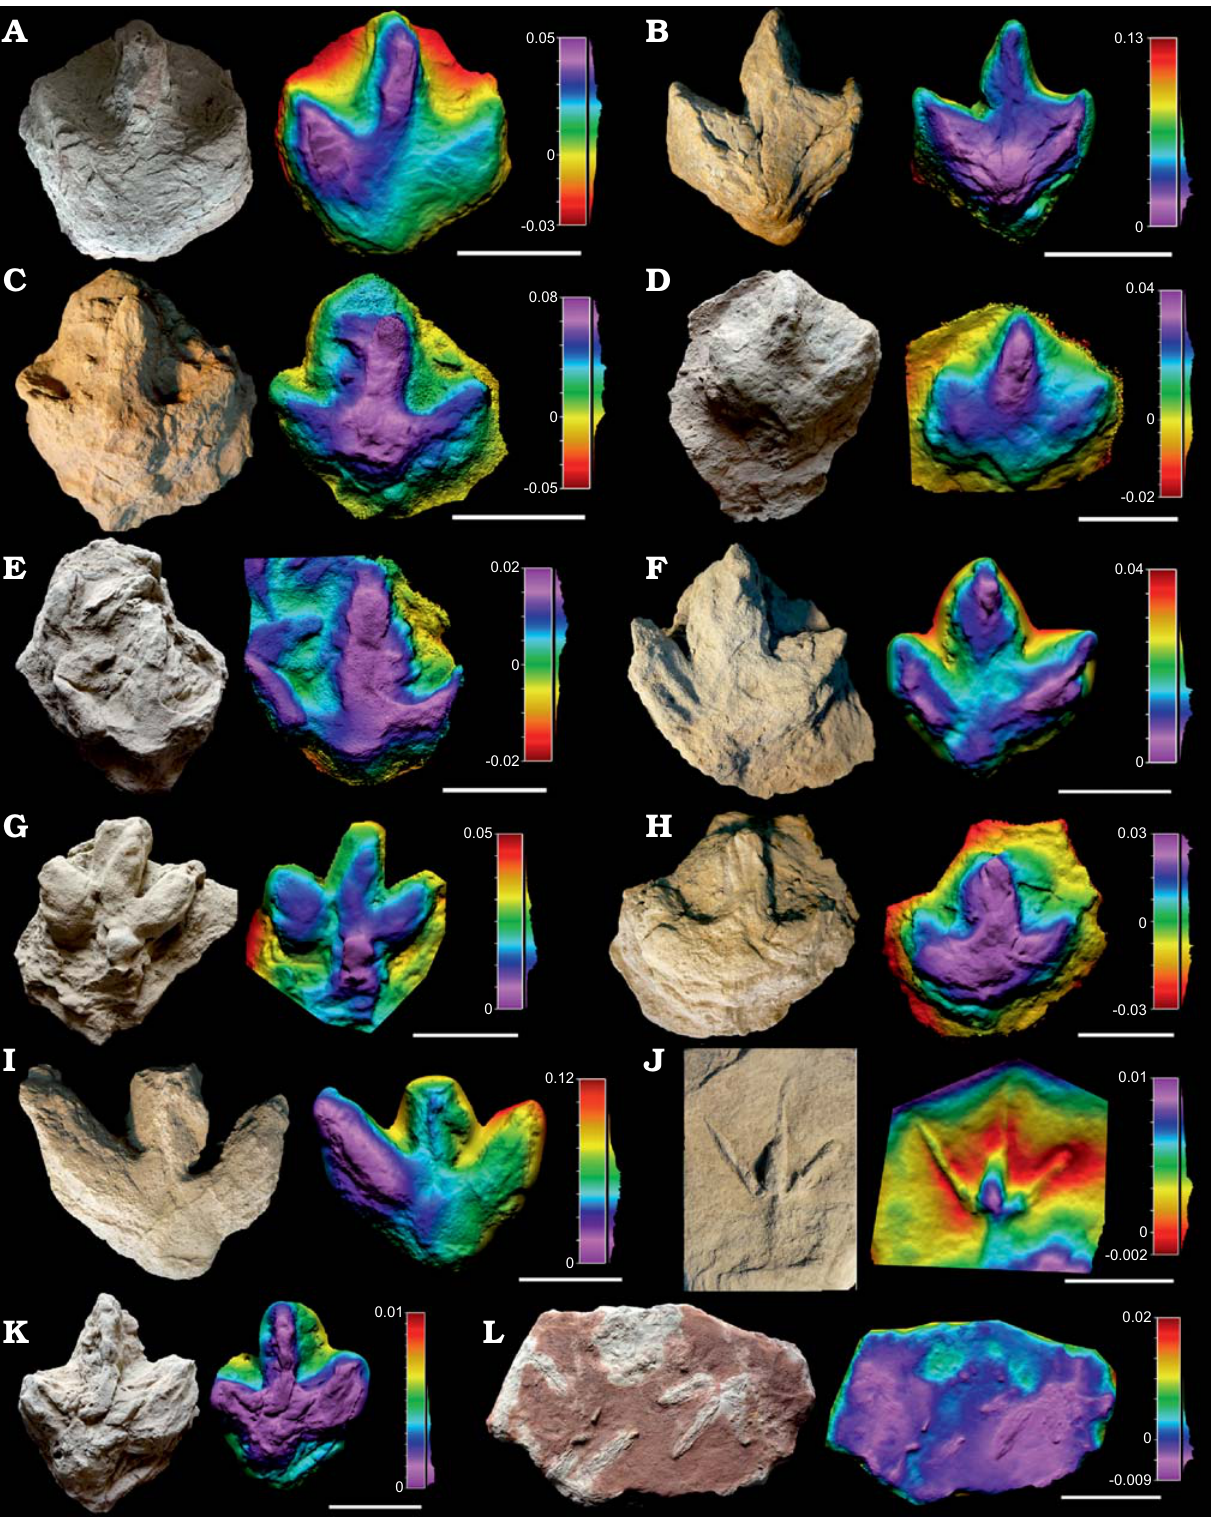
Fig. 7. Photographs, false-colour depth maps of the tracks of low morphological quality (MP < 2) of Ornithopoda indet. tracks, Portugal, Sobral Formation, upper Kimmeridgian–lower Tithonian (A–D), Freixial Formation, middle–upper Tithonian (E–K), and Alcobaça Formation, Kimmeridgian–lower Tithonian (L) A . SHN.(JJS).ICNO.21, Praia Azul. B . SHN.(JJS).ICNO.87, Praia Azul. C . SHN.(JJS).ICNO.97, Praia Azul. D . SHN.(JJS).ICNO.106,